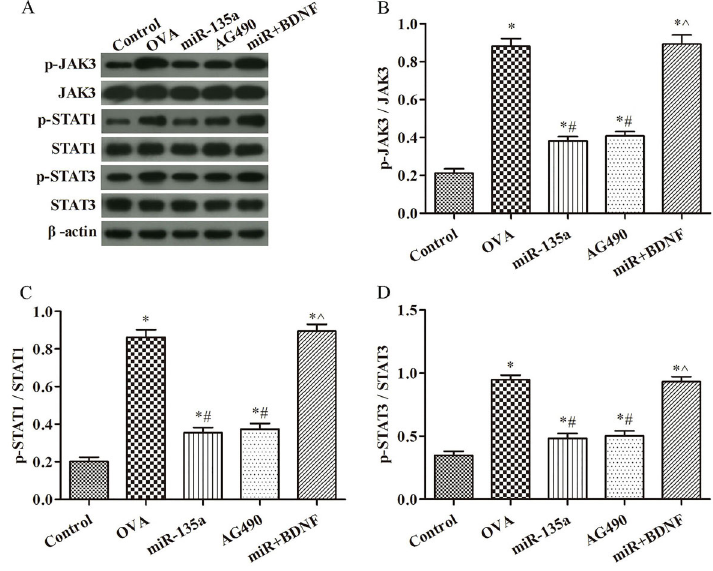
Figure 8. Effect of regulation of JAK/STAT signaling pathway on expression of pathway-associated proteins in mouse lung tissue. A , Protein band diagram; B , p-JAK3/JAK3; C , p-STAT1/STAT1; D , p-STAT3/STAT3. Data are reported as means ± SD. *P o 0.05 compared to the control group; # P o 0.05 compared to the ovalbumin (OVA) group; ̂ P o 0.05 compared to the miR-135a